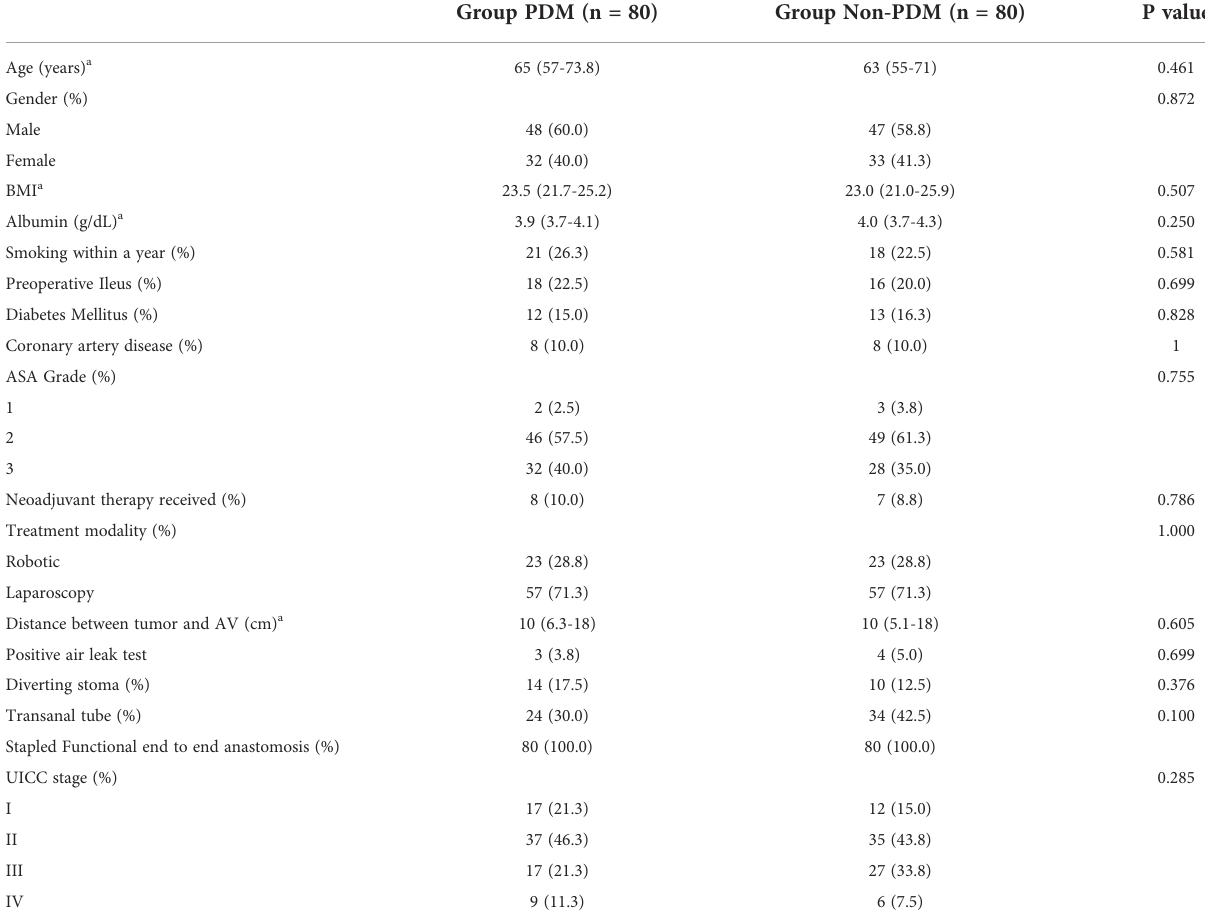
TABLE 4 Baseline characteristics and tumor locations after propensity score